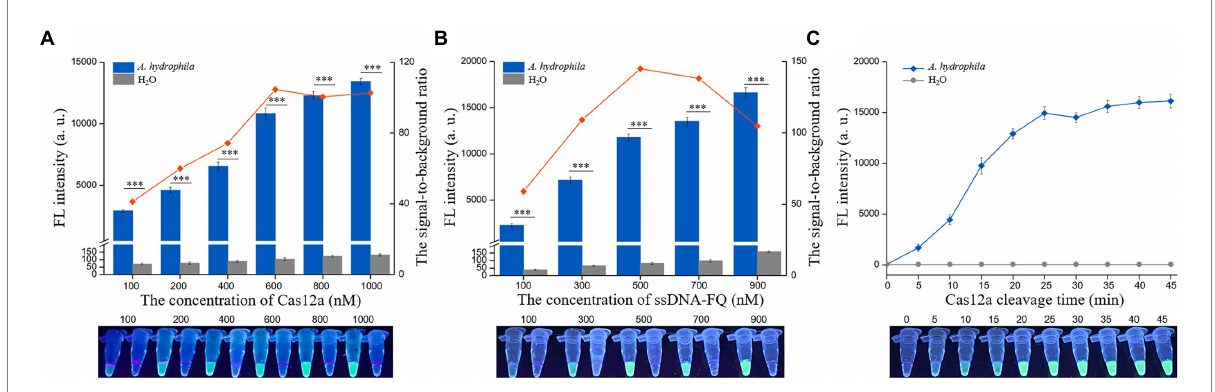
FIGURE 3 Optimization of the conditions of dRAA-CRISPR/Cas12a assay. The dRAA-CRISPR/Cas12a assays were conducted using AF5/AR5 and HF3/HR3 as RAA primer sets, aerA + hlyA + A. hydrophila genomic DNA (1 × 10 4 copies/ μ l) or H 2 O as a RAA template, and ACR1, ACR2, HCR1 and HCR2 as crRNAmix to optimize the concentration of Cas12a (A) and ssDNA-FQ (B) and the cleavage time of Cas12a (C) . The results were read using an UV flashlight (below) or a multifunctional microplate reader (upper). (A,B) n = 3 technical replicates; two-tailed Student’s t test; *** p < 0.001; bars represent mean ±